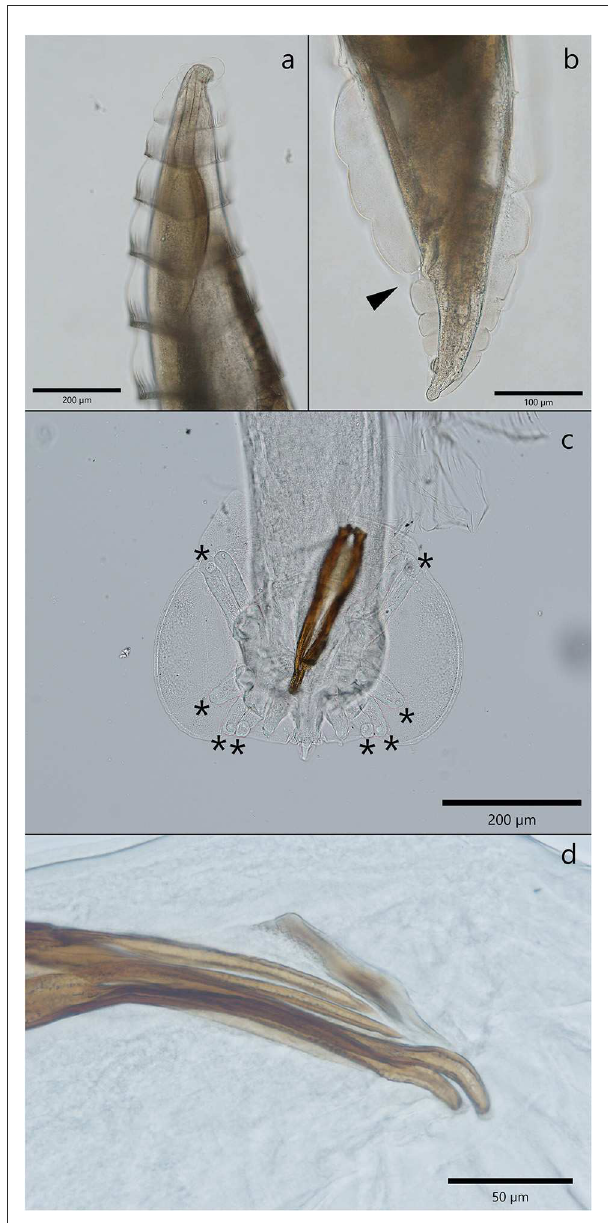
FIGURE2 Morphological characteristics of C. melesi. (a) The specific circular folds. (b) Caudal extremity of a female with the cuticular folds visible and the anal opening marked with an arrow head. (c, d) Morphological characteristics of a male C. melesi . (c) The trilobated copulatory bursa with the presence of terminal globular papilla in each ray (asterix); (d) note the spicules splited in two